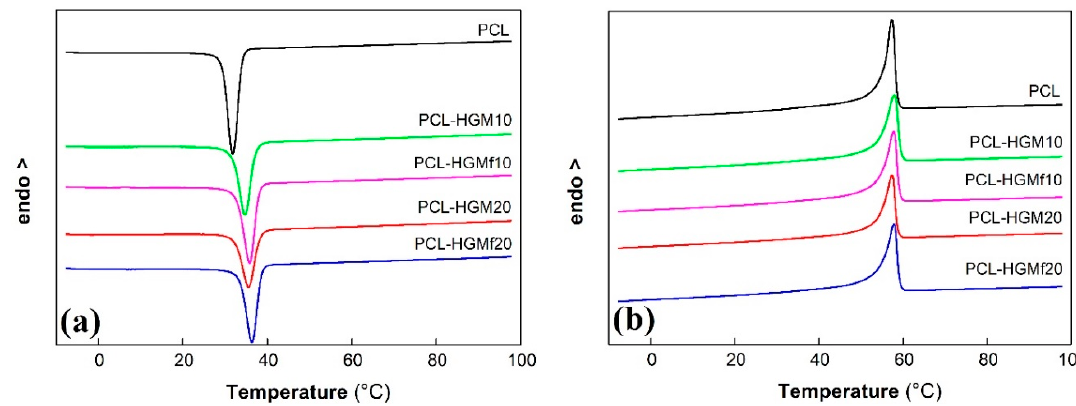
Figure 7. DSC cooling scans ( a ) and DSC successive heating scans ( b ) of PCL and selected PCL-based composites.